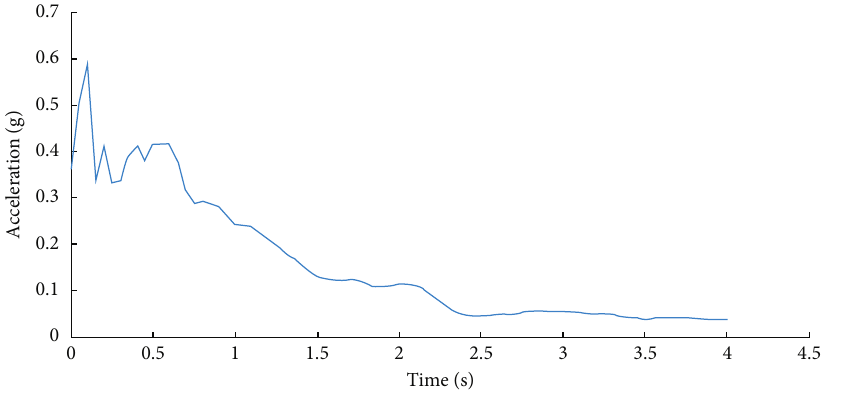
Figure 2: Acceleration response spectrum of the Chi-Chi earthquake [22].